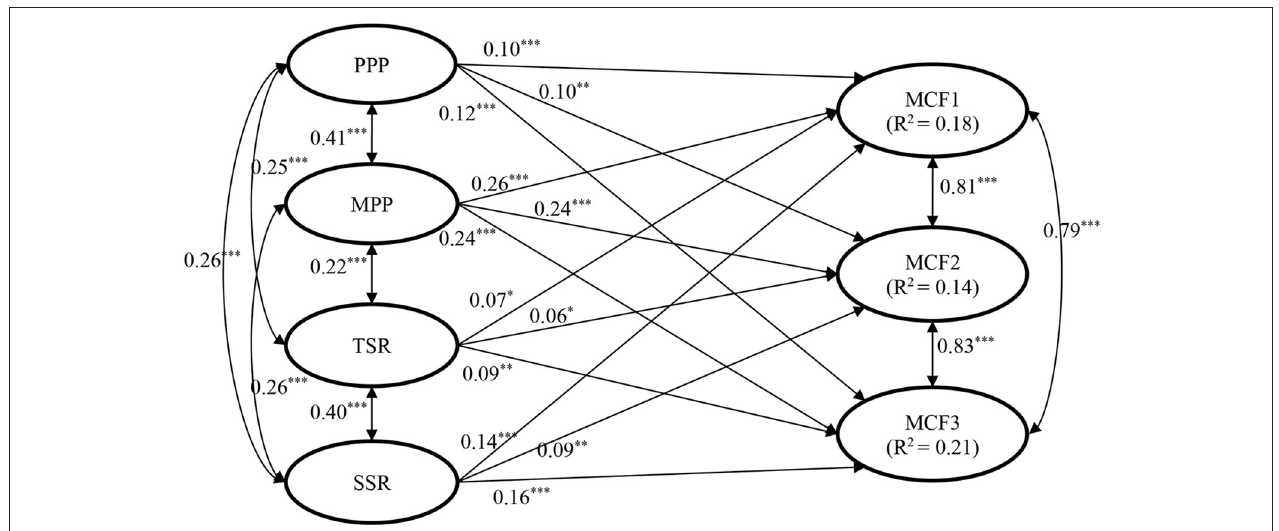
FIGURE 1 | Standardized results of structural equation modeling on the relationships between parental and school factors and adolescent moral character in Study 1. Age, gender, family intactness, and family economic status were controlled. The control variables, observed indicators, and residuals were not shown in the figure. PPP, paternal positive parenting; MPP, maternal positive parenting; TSR, teacher–student relationship; SSR, student–student relationship; MCF1, moral character factor 1 (i.e., treating others well); MCF2, moral character factor 2 (i.e., self-discipline and law-abidance); MCF3, moral character factor 3 (i.e., traditional Chinese virtues). χ 2 = 3559.789, df = 819, χ 2 /df = 4.34, CFI = 0.924, NNFI = 0.917, RMSEA = 0.041, SRMR = 0.037. * p < 0.05; ** p < 0.01; *** p <